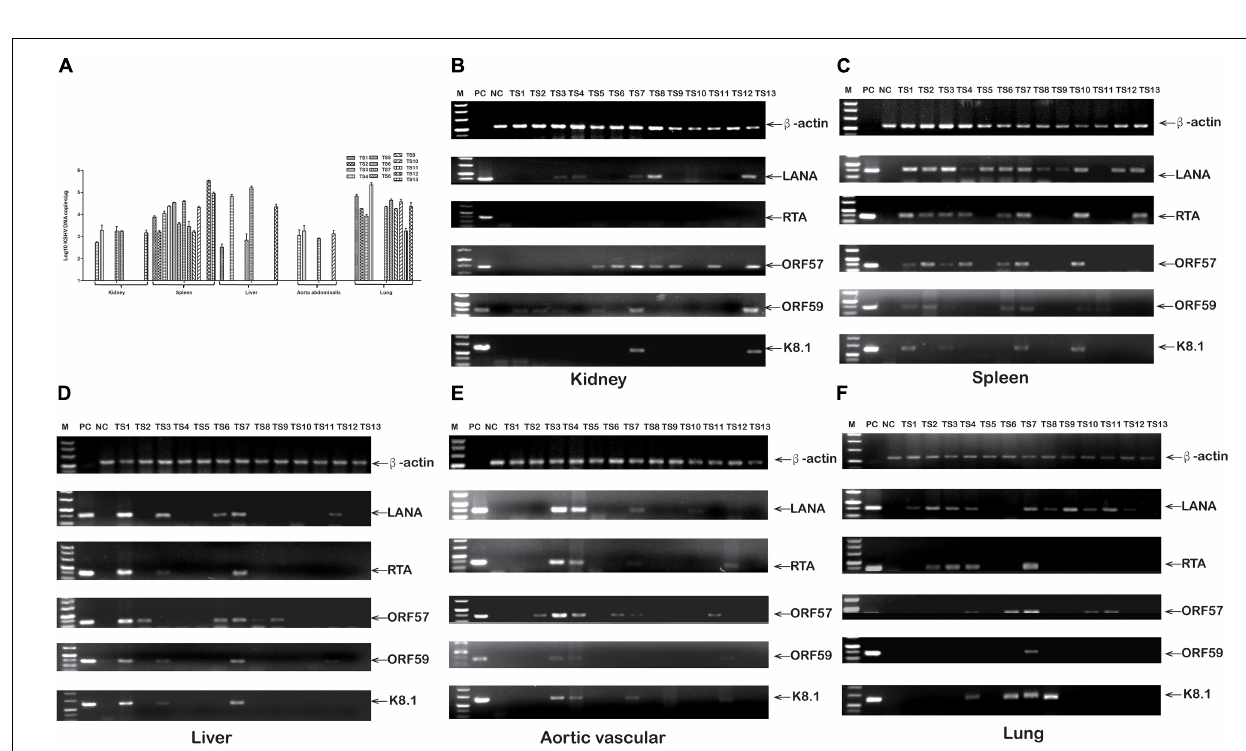
FIGURE 6 | rKSHV.219 DNA copies and mRNA transcripts in multiple tissues of TS1-13 tree shrews. (A) rKSHV.219 DNA copies in the different tissues. (B) rKSHV.219 mRNA transcripts in the kidney. (C) rKSHV.219 mRNA transcripts in the spleen. (D) rKSHV.219 mRNA transcripts in liver. (E) rKSHV.219 mRNA transcripts in thoracic aorta. (F) KSHV mRNA transcripts in lung. (M, DL500 DNA Marker; NC, negative control; PC, positive control).